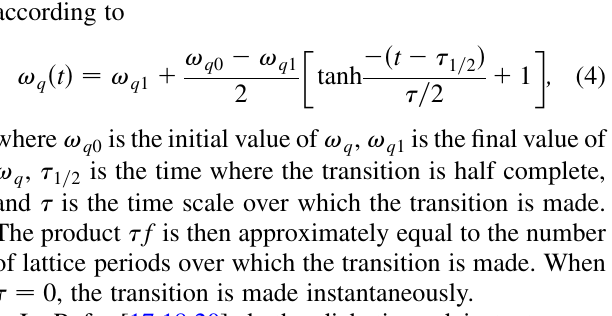
FIG. 2. The average radial density profile n self-consistently from numerical integration of Poisson’s equa- tion and Eq. (2). The parameter (cid:8) (cid:3) N versus the normalized beam intensity parameter s . The profile is Gaussian in the limit of weak space charge, s ! 0 and (cid:8) (cid:3) 1 . The profile is uniform when s ! 1 and (cid:8) (cid:3) 2 , corresponding to a space-charge-dominated